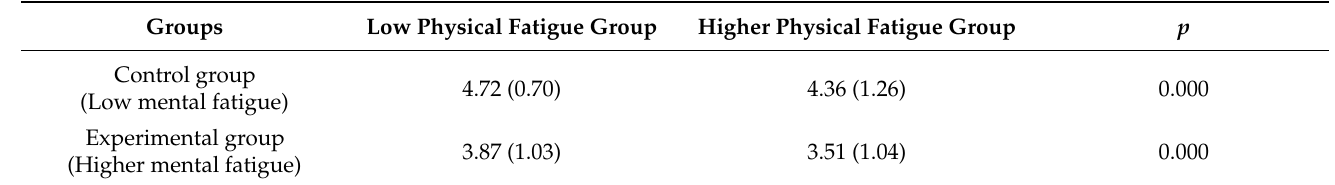
Table 7. Simple effects analysis of farmers’ participation in rural tourism